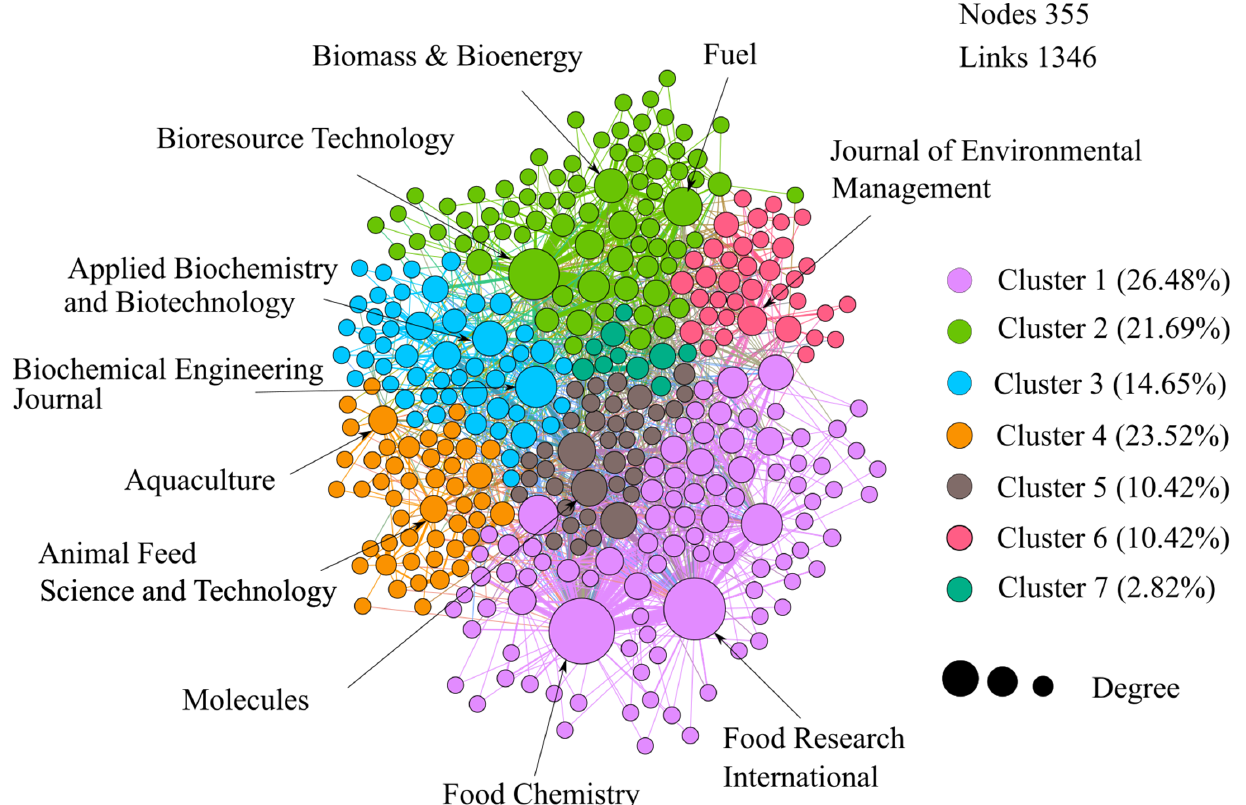
Figure 6. Journal citation network.